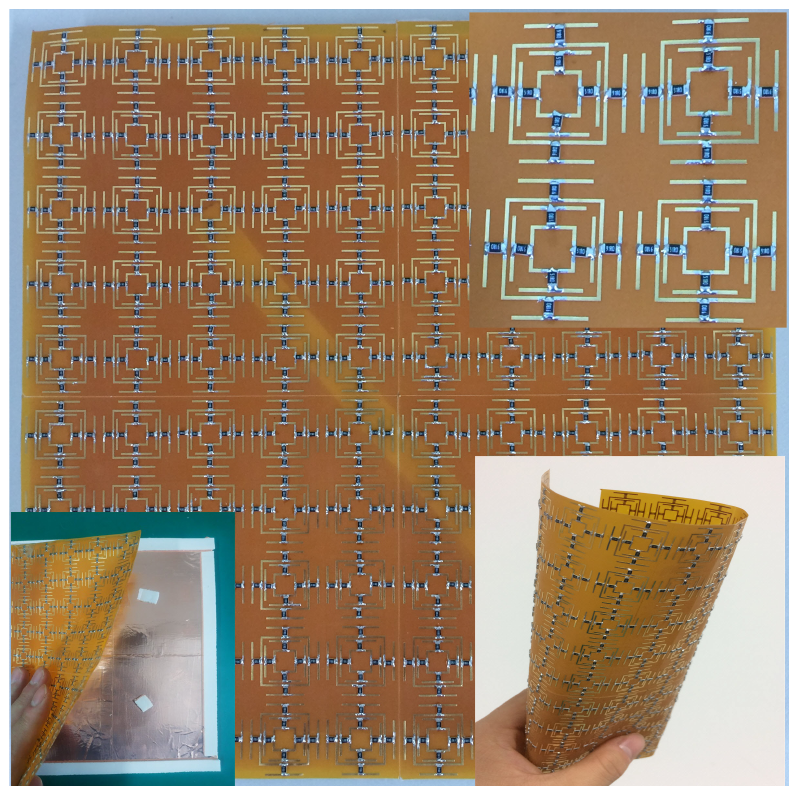
Figure 8. Photograph of the fabricated absorber.